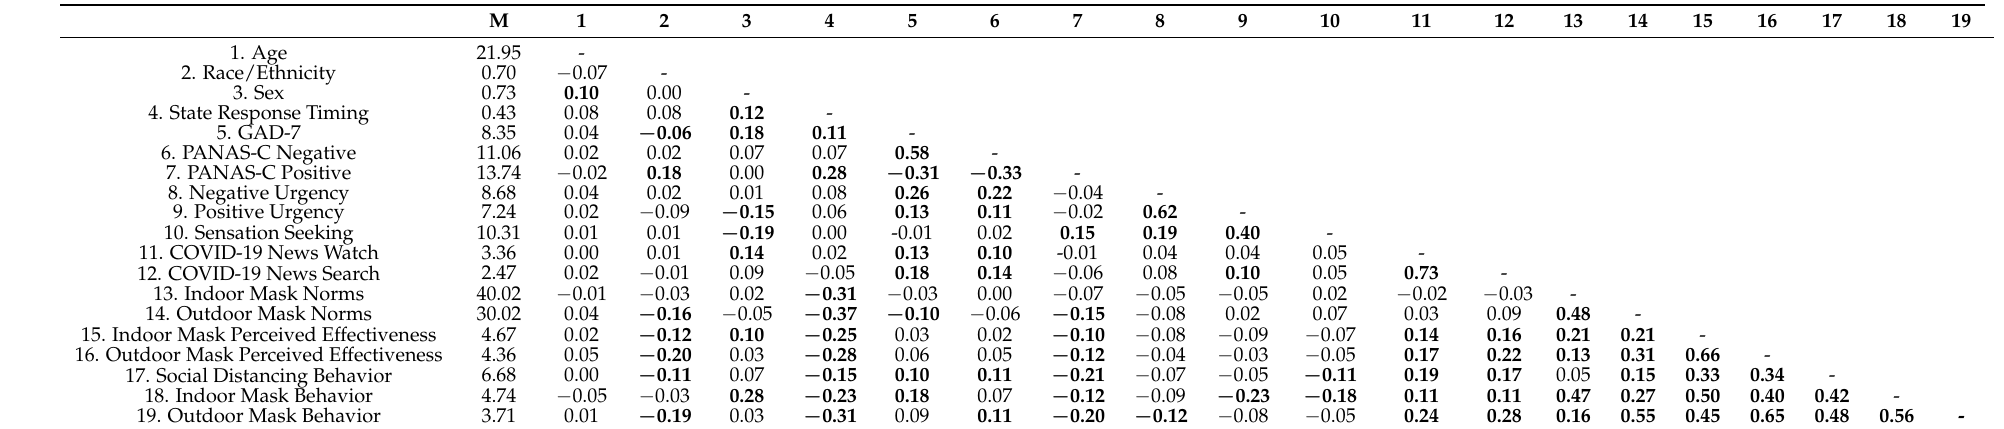
Table 1. Means (M) and correlations among demographic, individual, and COVID-19